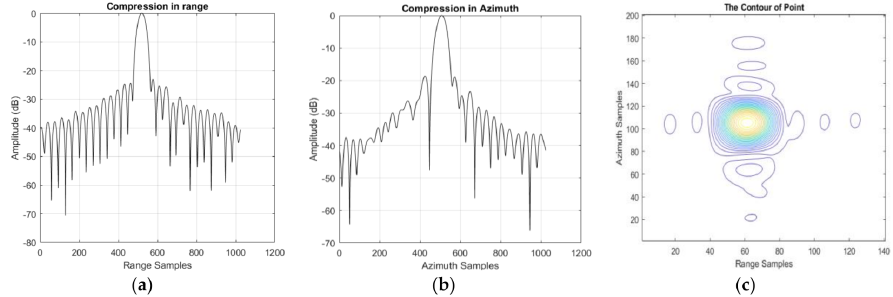
Figure 9. The compression result after stop-and-go correction. ( a ) The compression result of the corner reflector in slant range; ( b ) The compression result of the corner reflector in azimuth; ( c ) The two-dimension contour in azimuth and slant